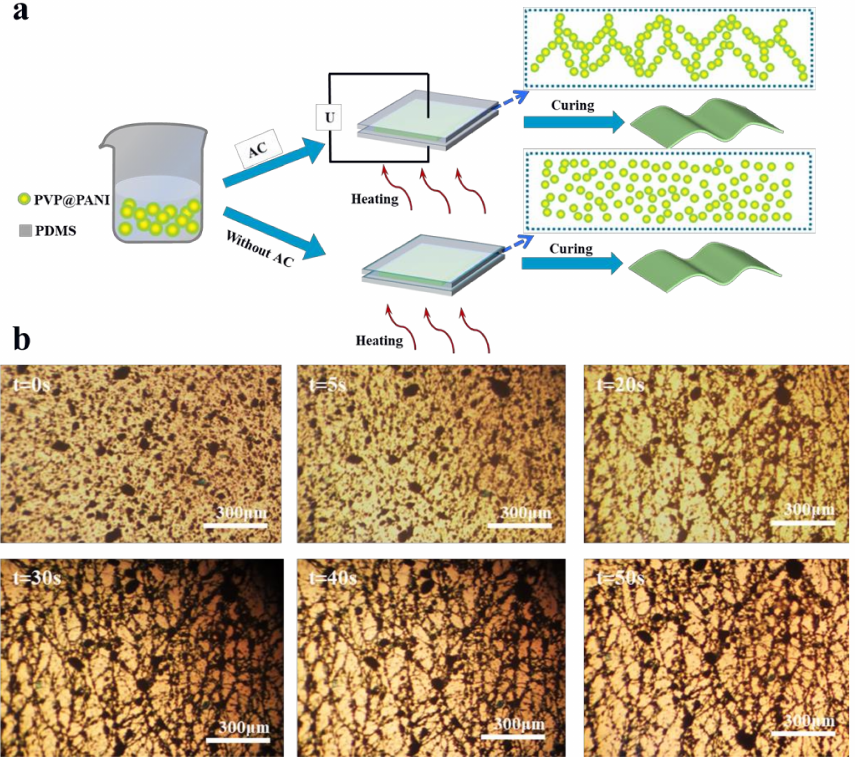
Figure 4. Schematic diagram of the preparation of PVP@PANI/PDMS composites. ( a ) Preparation of PVP@PANI/PDMS composites. ( b ) Micrograph of PVP@PANI particles to form a network